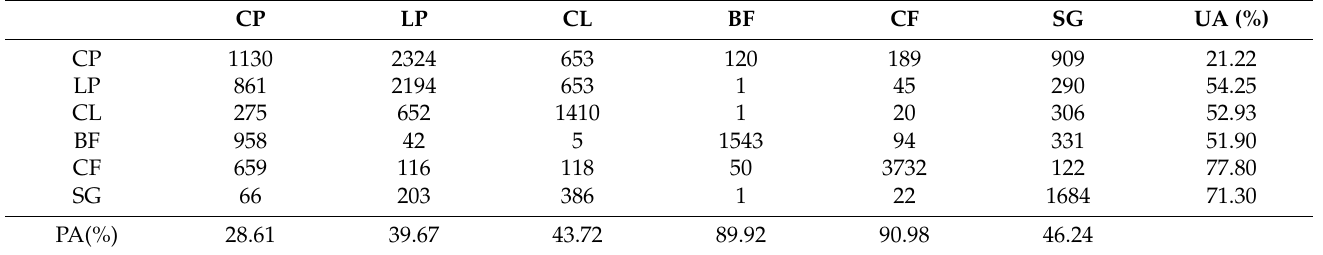
Table 1. Confusion matrix of the classification results of PolSAR data after GTC (i.e., no correction).